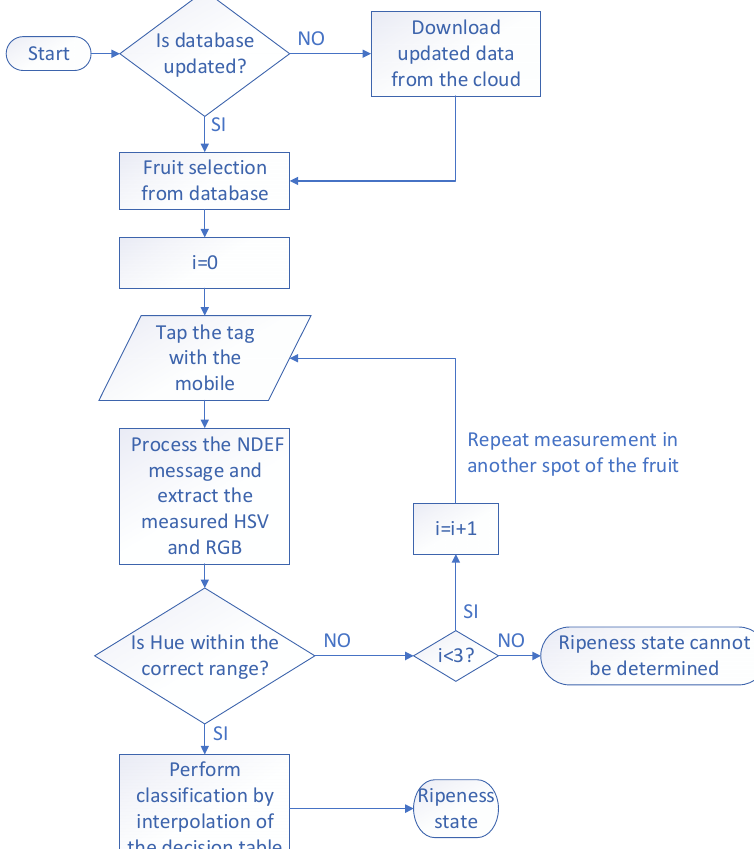
Figure 18. Flowchart of the mobile application.